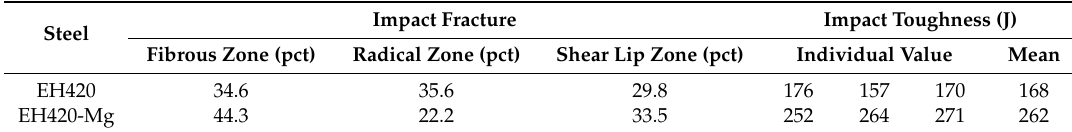
Table 2. Statistical analysis of fracture surface and impact toughness of HAZ at − 20 ◦